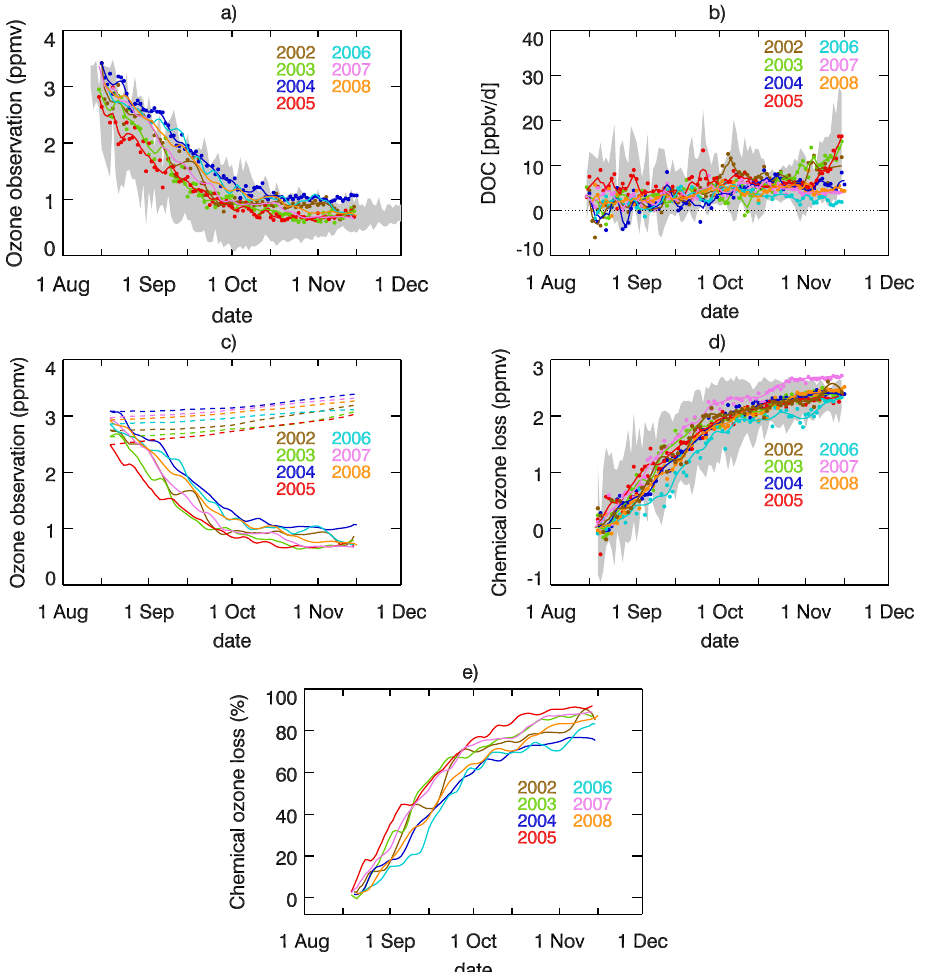
Fig. 9. Chemical ozone loss results for the Antarctic polar vortices 2002 to 2008 at the 475K isentropic level. (a) Observed vortex average ozone mixing ratio time series. (b) Daily ozone mixing ratio change (DOC) due to diabatic descent determined with MIDRAD model simulations. (c) Accumulated ozone mixing ratio from daily diabatic descent (dashed lines) and the observed ozone mixing ratio time series (solid lines). (d) Chemical ozone losses inppmv relative to the mean of the period August 15 – 22 and starting on August 18. (e) Chemical ozone loss in percent relative to the mean of the period August 15 – 22 of each year and starting on August 18.